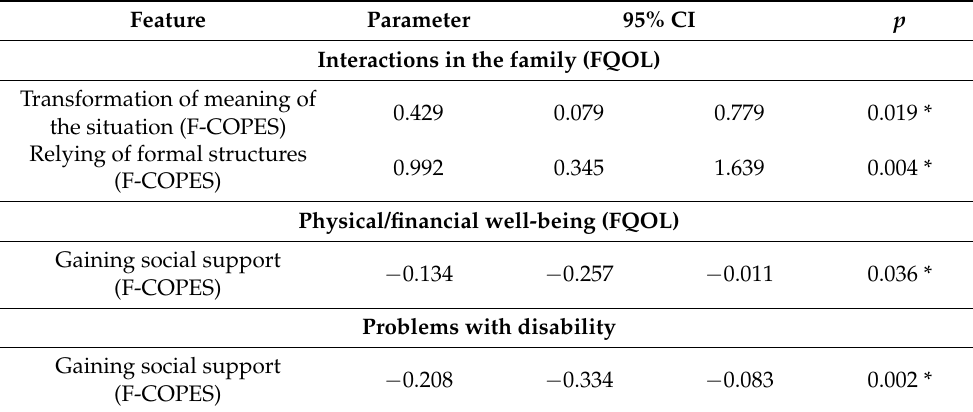
Table 5. Multivariate analysis of the influence of independent variables on family interactions. Physical and financial well-being (FQOL) assessed by children and adolescents with